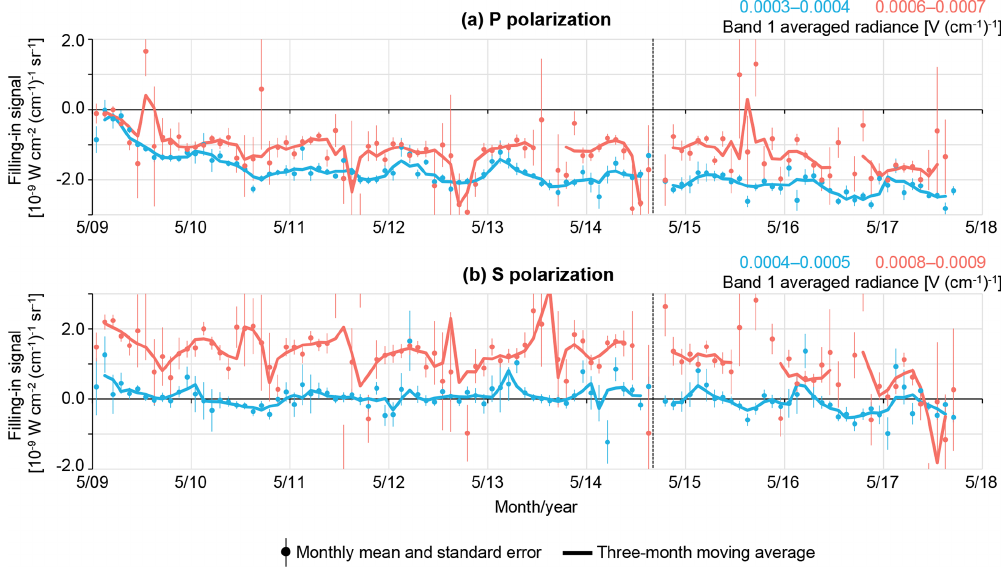
Figure 3. Temporal variation of the zero-level offset evaluated from bare soil within the latitude zone of 30 to 45 ◦ N: (a) P polarization; (b) S polarization. Results for different ranges of the observed radiance are depicted in each panel. The bare soil data were identified by the criteria determined in Sect.